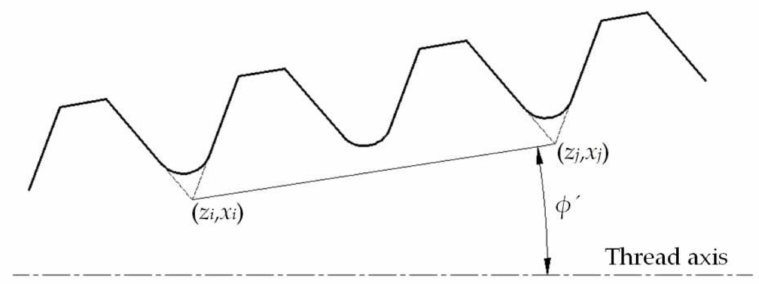
Figure 13. Diagram of taper